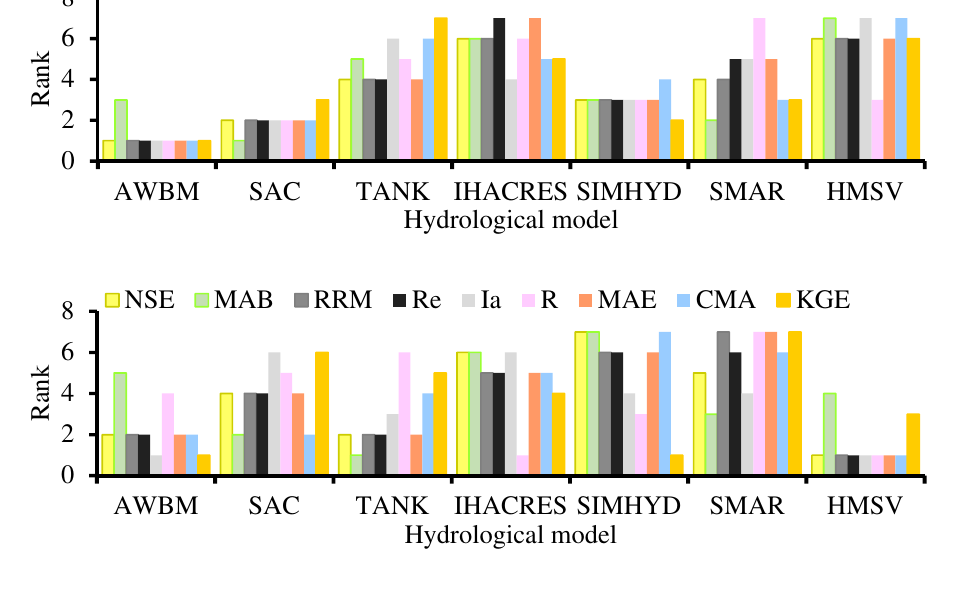
Fig. 10 Comparison of expo- nential quantile–quantile plot for the high flow POT events considering 1-day aggregation level. The markers represent the empirical, solid lines signify theoretical (calibrated distribu- tion), while dashed lines repre- sent extrapolated